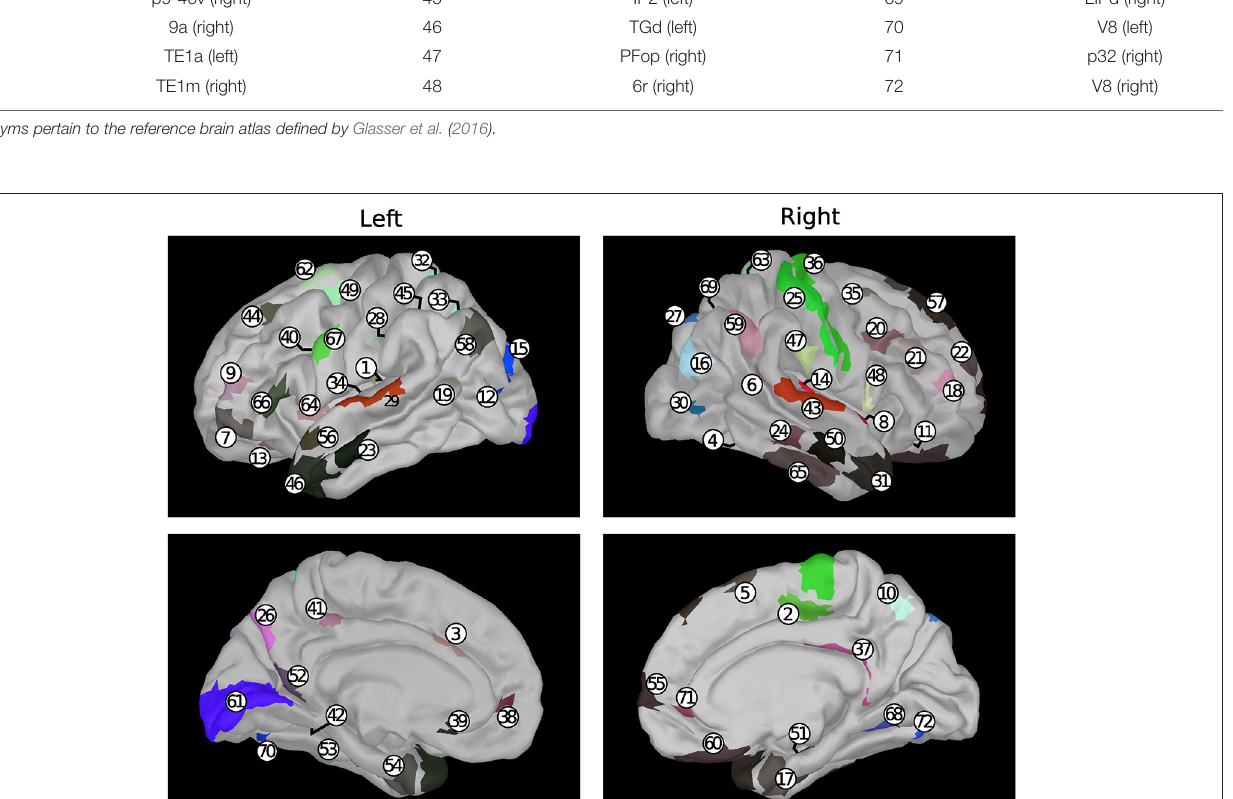
Frontiers in Physiology |